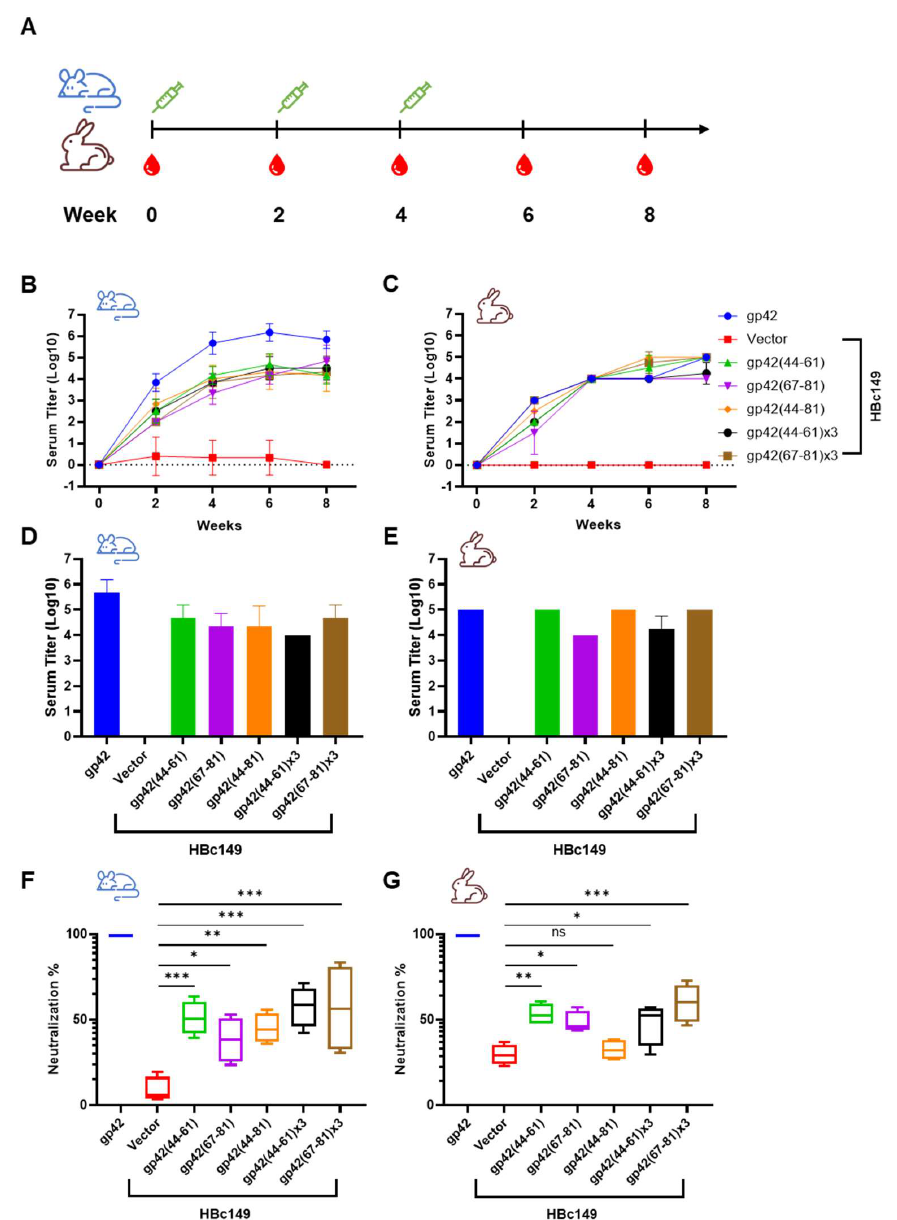
Figure 7. Immunogenicity analysis of chimeric VLPs. ( A ) Schematic diagram of immunization procedure. Mice ( n = 6) and rabbits ( n = 4) were immunized three times at 2-week intervals. Blood samples were collected five times at 2-week intervals. ( B , C ) The serum titers of ( B ) mice and ( C ) rabbits against gp42 from different timepoints were assessed by ELISA assay. ( D , E ) The antibody titers of ( D ) mice and ( E ) rabbits against gp42 were evaluated at week 8. ( F , G ) Neutralizing assessment of serum samples collected at week 8 from ( F ) mice and ( G ) rabbits. All data are presented as mean ± SEM. * p < 0.05; ** p < 0.01; *** p < 0.001; ns, not